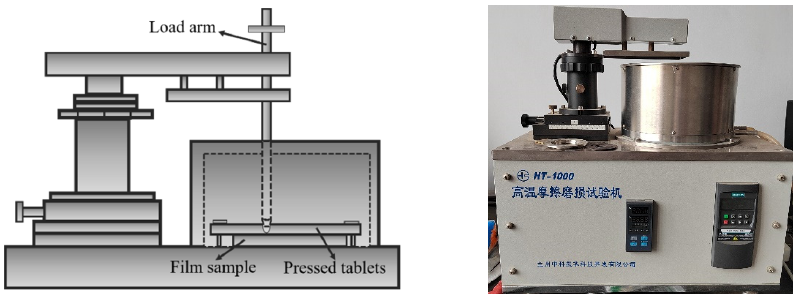
Figure 1. A ball on disc tribometer is used for wear and friction tests.